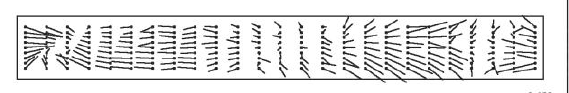
Figure 9. Filtered discrepancies